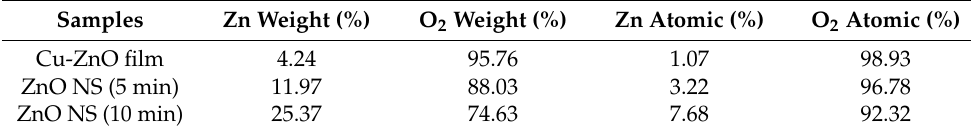
Figure 4. EDS analysis area of the ZnO film ( a ); EDS analysis area of the ZnO NS on which the H 2 reduction process was carried out for five minutes ( b ) and 10 min ( c ); graph ( d ) of the ratios of Zn and O 2 in the ZnO film and the ZnO NS. Table 4. Weight ratio and atomic ratio of Zn and O 2 for the ZnO NS.